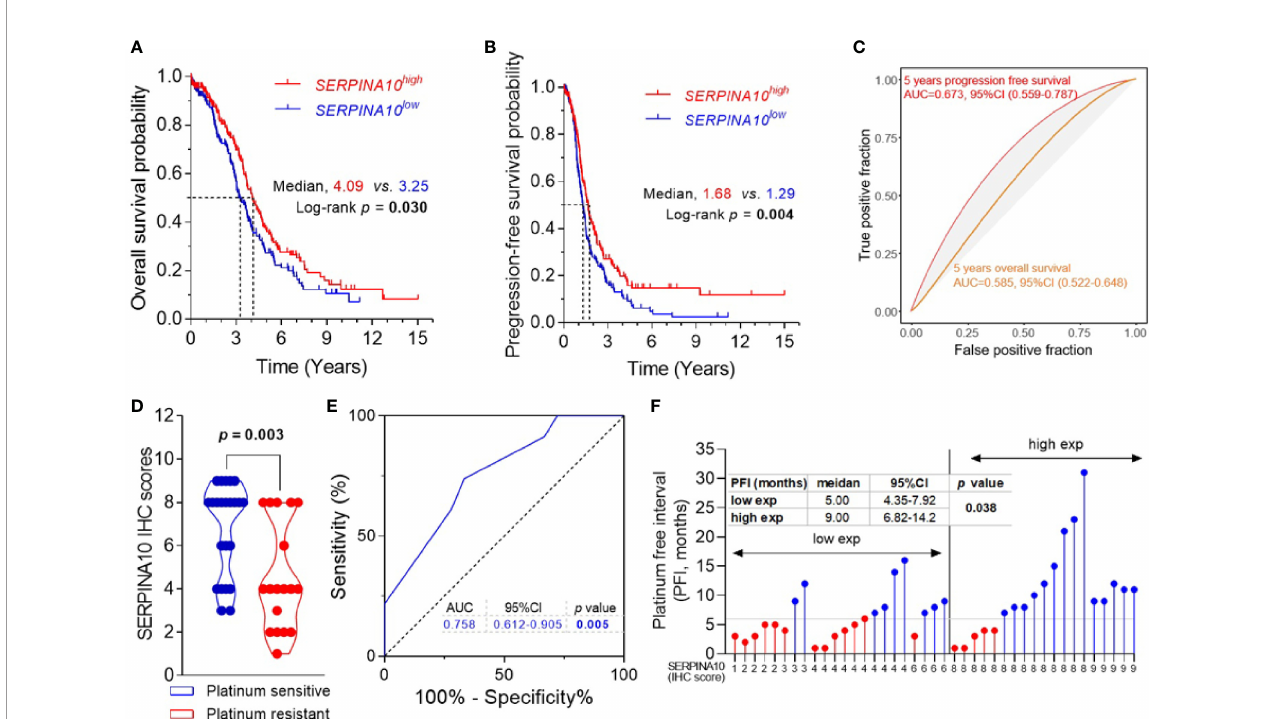
FIGURE 4 | Prognostic and predictive value of SERPINA10 expression for platinum sensitivity and survival of high-grade serous ovarian cancer (HGSOC) patients. (A, B) Kaplan – Meier analysis of overall survival (OS) and progression-free survival (PFS) for The Cancer Genome Atlas (TCGA) ovarian cancer cohort, strati fi ed by median value of SERPINA10 mRNA expressions. Medians of survival (OS and PFS) and log-rank p -Values were indicated, respectively. (C) Time-dependent receiver operating characteristic (ROC) curves of SERPINA10 expression for the predictions of 5-year OS and PFS. Expression data of RNA-sequencing and survival data of ovarian cancer were acquired from TCGA dataset. (D) Immunohistochemical staining of SERPINA10 expression in HGSOC patients. p -Values were calculated by Mann – Whitney test. (E) ROC curves of SERPINA10 expression in predicting platinum-sensitivity status of HGSOC patients who were receiving platinum-based chemotherapy treatment after cytoreductive surgery. The AUC was the highest for the SERPINA10 expression (AUC = 0.758; 95% CI = 0.612 – 0.905; p = 0.005). (F) Correlation analysis of SERPINA10 expression and platinum-free interval (PFI) in HGSOC patients. Grouping of HGSOC patients according to their immunoreactive scores (cutoff = 6) into low exp (n = 22) or high exp (n = 19). p -Value was calculated by Mann – Whitney test. AUC, area under the